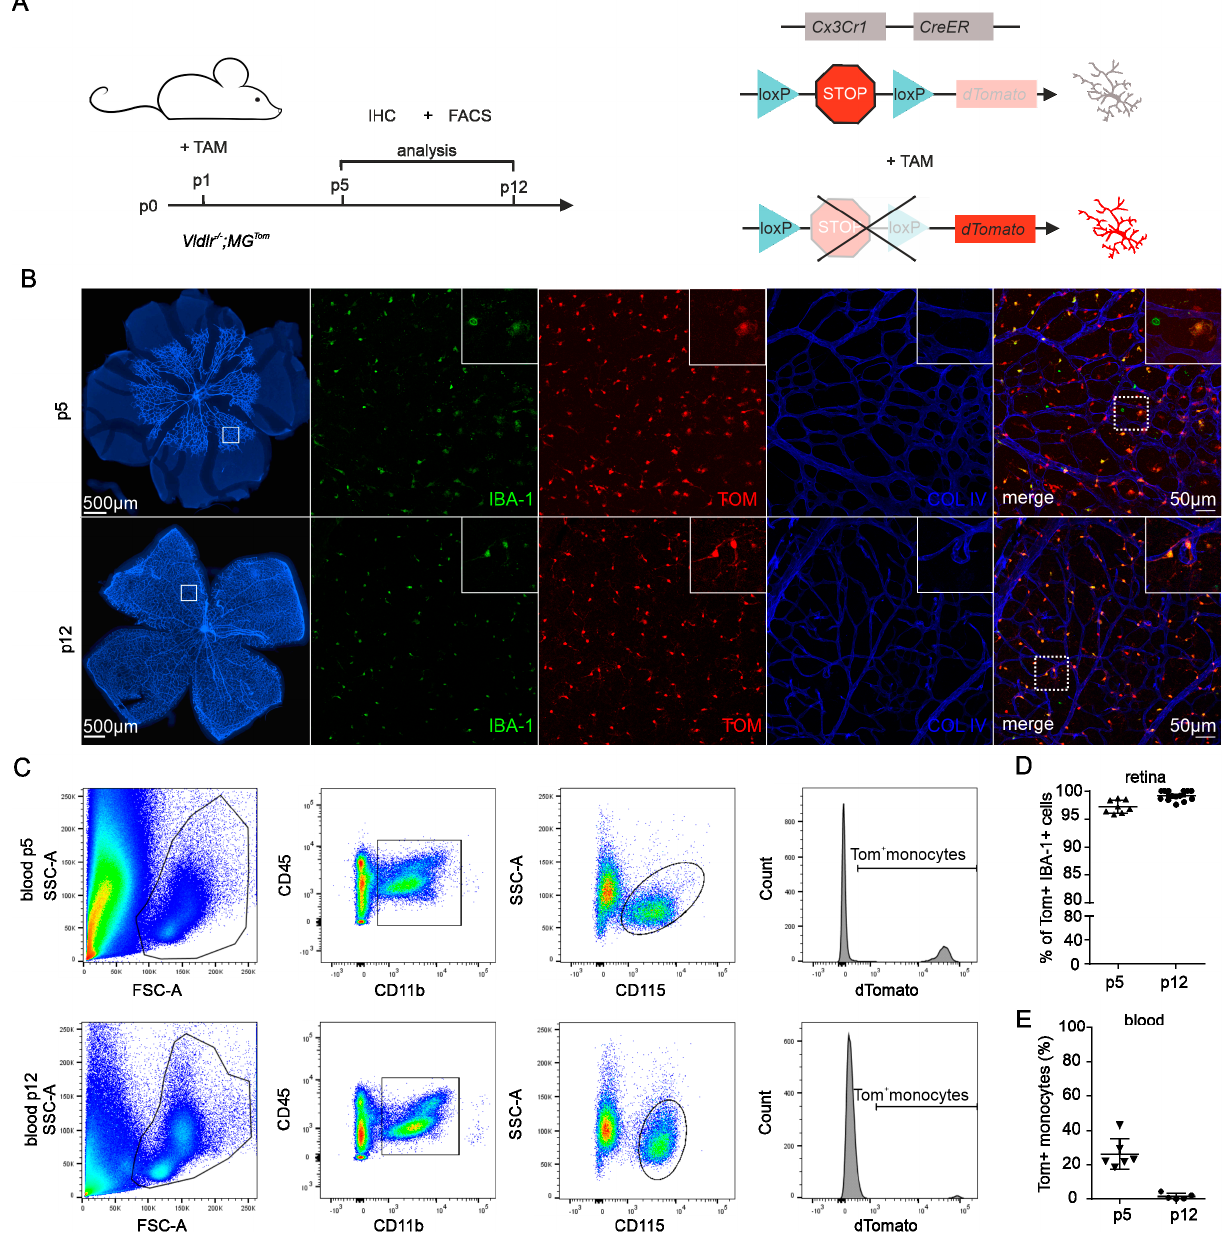
Figure 1. Recombination efficiency in retinal microglia and blood of Vldlr − / − ; MG Tom mice. ( A ) Scheme displaying the experimental setup and timeline (left-hand side panel) for induction of reporter expression (right-hand side panel). Newborn Vldlr − / − ; MG Tom mice were injected with tamoxifen (TAM) on postnatal day (p)1. Flow cytometry (FACS) and immunohistochemistry (IHC) were performed at p5 and p12. ( B ) Immunofluorescence of retinal vessels (Collagen IV (COLIV) staining, blue) and microglia (IBA1, green) at p5 and p12 following tamoxifen treatment at p1. TAM injection at p1 leads to efficient tdTomato (TOM, red) labeling of most microglia. In the top right corner of each image, a magnified image of the area within the dashed white box is displayed. ( C ) Flow cytometry analysis of the recombination efficiency in monocytes of Vldlr − / − ; MG Tom mice at p5 and p12. Monocytes were gated as a CD45 hi CD11b + CD115 + Ssc lo cell population